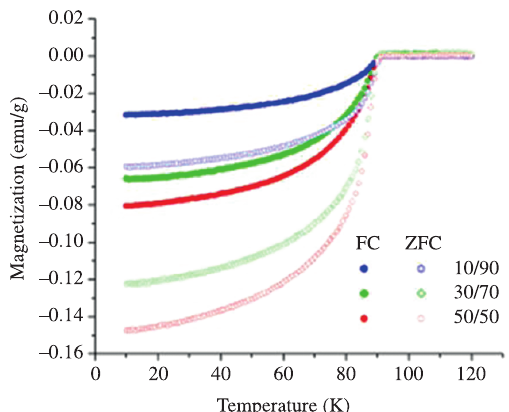
Figure 4. Critical temperature and Meissner effect for (50/50, 30/70 and 10/90) YBCO/BZO composites in curves of DC magnetization as a function of